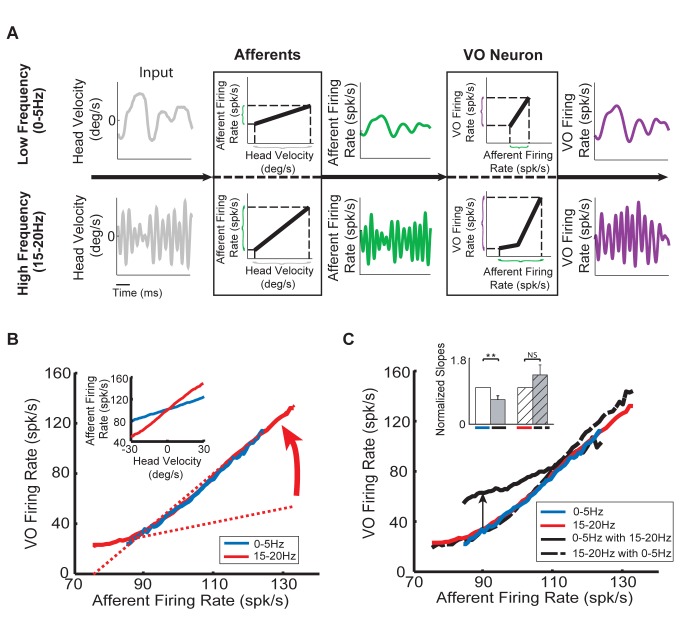
Central neurons display a static nonlinear relationship between their output firing rate and their afferent input.(A) Low (top) and high (bottom) frequency head velocity stimuli (gray) cause smaller and larger changes in afferent firing rate (green), respectively. These differential changes in afferent firing rate in turn cause differential changes in central neuron firing rate (purple), respectively. Notably, the changes in afferent firing rate caused by high frequency head velocity stimuli are distributed over a greater range and thus elicit nonlinear responses from VO neurons, whereas this is not the case for those caused by low frequency head velocity stimuli. Note that the same scales were used for corresponding panels in the bottom and upper rows. (B) Population-averaged firing rates of central VO neurons as a function of afferent firing rate for low (blue) and high (red) frequency noise stimuli presented in isolation. Note that the curve obtained for the low frequency stimulus (blue) extends over a smaller range than that obtained for high frequency (red) stimuli. Further, both curves are linear over the range for which they overlap. Also shown are best linear fits to the portion of the curve below and above 90 Hz (dashed red lines). As such, the curve can be approximated by a piecewise linear function. Inset: population-averaged firing rates of afferents as a function of the head velocity stimulus for low (blue) and high (red) frequency noise stimuli presented alone. (C) Population-averaged firing rates of central VO neurons as a function of afferent input firing rates: (1) for the low frequency stimulus when presented alone (blue) and concurrently with the high frequency stimulus (solid black); (2) for the high frequency stimulus when presented alone (red) and concurrently with the low frequency stimulus (dashed black). Note that the curves obtained in response to the high frequency stimulus when presented alone (red) and when presented concurrently with the low frequency stimulus (dashed black) overlapped before (Figure 3E) and thus, not surprisingly, also overlap. Note also that only the curve obtained when the low frequency stimulus was presented concurrently with the high frequency stimulus (solid black) does not overlap with the others. This is because the central VO neuron firing rate is higher than that obtained for the low frequency stimulus when applied alone for values lesser than 110 Hz. Inset: population-averaged normalized slopes under all four conditions. The afferent activity was estimated by fitting a linear model to previous experimental recordings from a large population of afferents (see Materials and Methods).